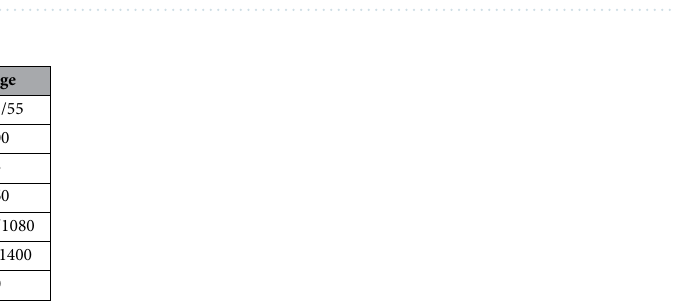
Table 1. Access to different APIs.